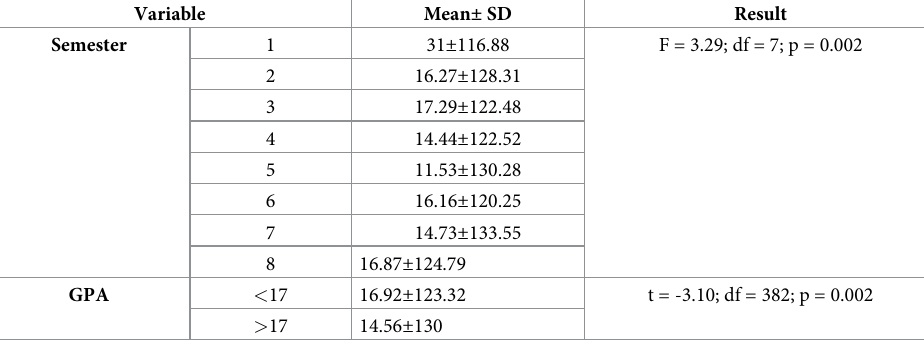
Table 6. Distribution of resilience scores in nursing